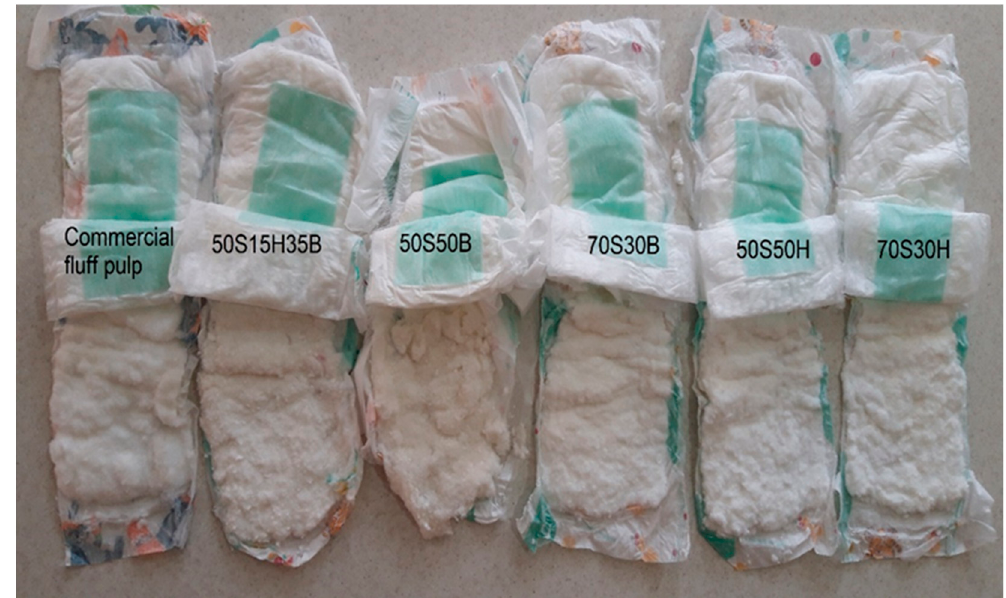
Figure 6. Defibration type of fluff pulp in the baby diapers.